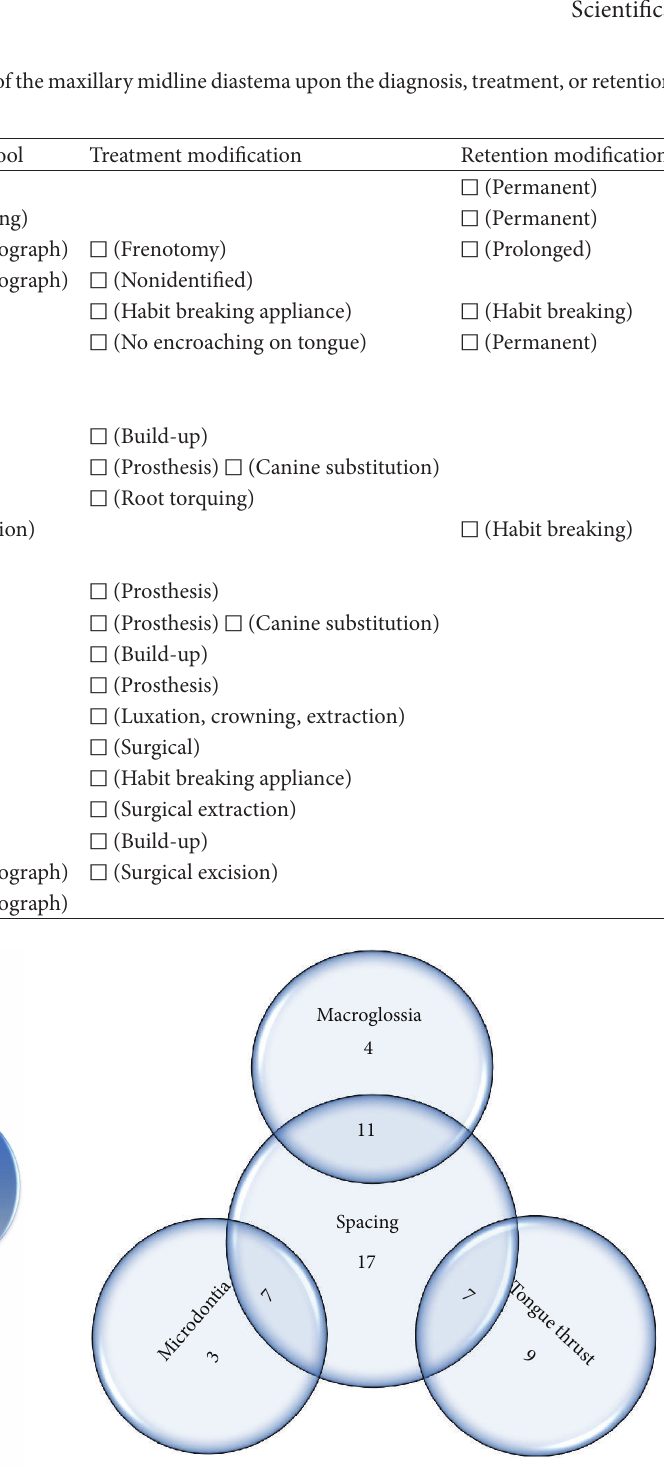
Figure 5: Intersecting circles chart depicting the common occur- rence between spacing, microdontia, macroglossia, and tongue